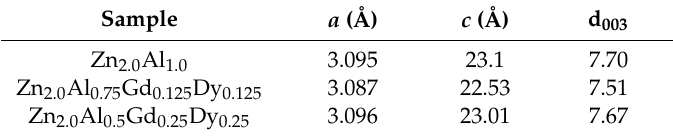
Table 2. The lattice parameters and basal spacing of LDH prepared.